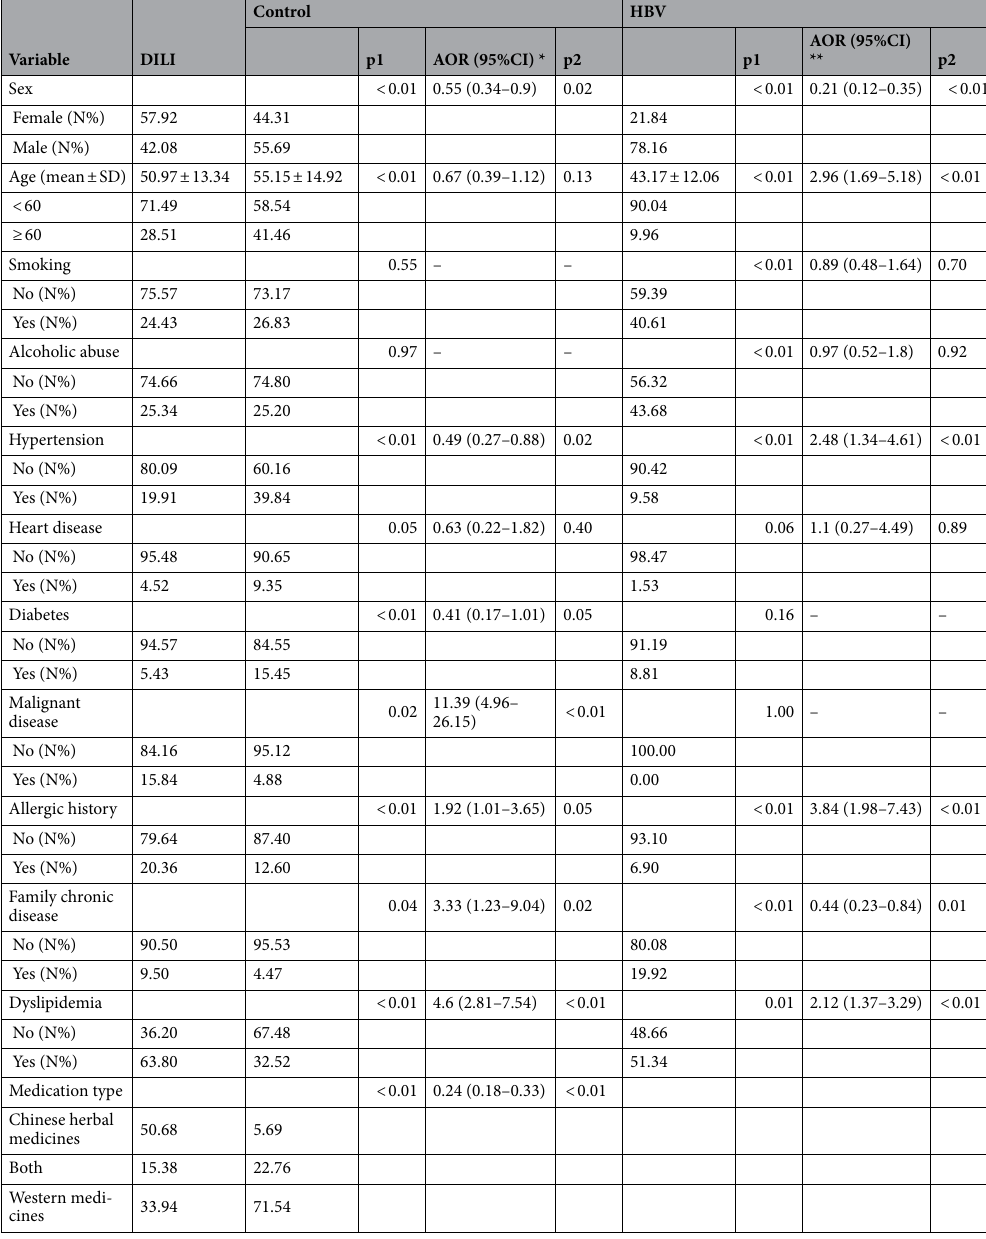
Table 1. Univariate analysis and multivariate analysis of patients’ characters in DILI and control groups. DILI drug induced liver injury, AOR adjusted odds ratio. p1 p value for univariate analysis, p2 p value for multivariate analysis. *Adjusted for sex, age, hypertension, heart disease, diabetes, history of malignancy, allergic history, family chronic diseases, dyslipidemia and medication type. **Adjusted for sex, age, smoking, alcoholic abuse, hypertension, heart disease, allergic history, family chronic diseases and